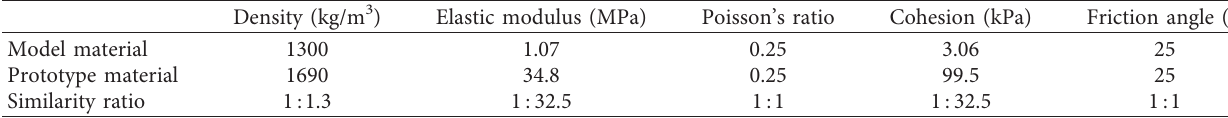
Table 3: Physical parameters of the surrounding rock.